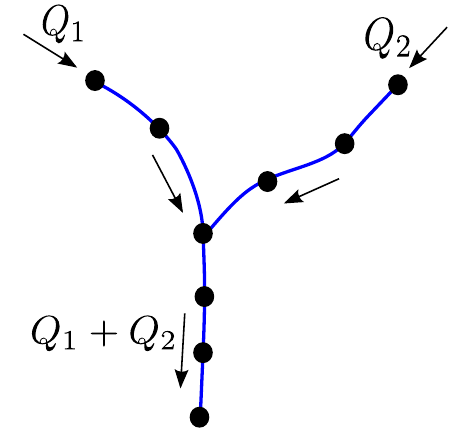
Figure 1. Propagation of flow rate Q at a junction.